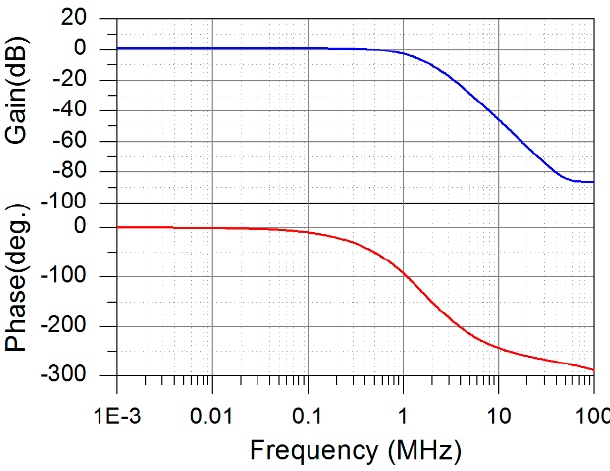
Figure 16. Frequency responses of gain and phase of the third-order LP filter.